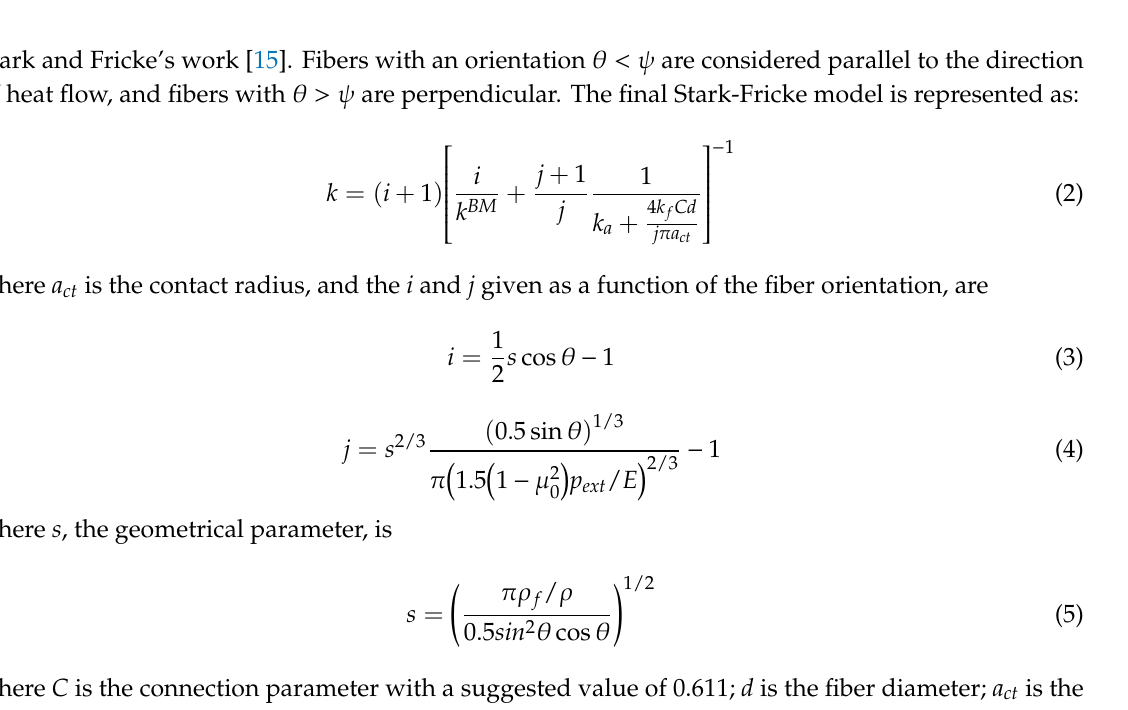
Figure 4. Polyester nonwoven samples ( a ) and cross-sectional macroscopic images (b). Figure 5. Tomography image of polyester nonwoven sample TK7. The characterization of polyester nonwoven fibrous samples has been reported in our previous work, as listed in Table 3 [32]. From Figure 5, it can be seen that the fibers were orientated in the same direction and had a similar orientation angle. Thus, it was assumed that the fibers were generally